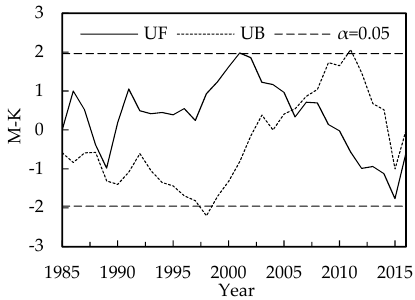
Figure 3. Mutation test of annual precipitation.